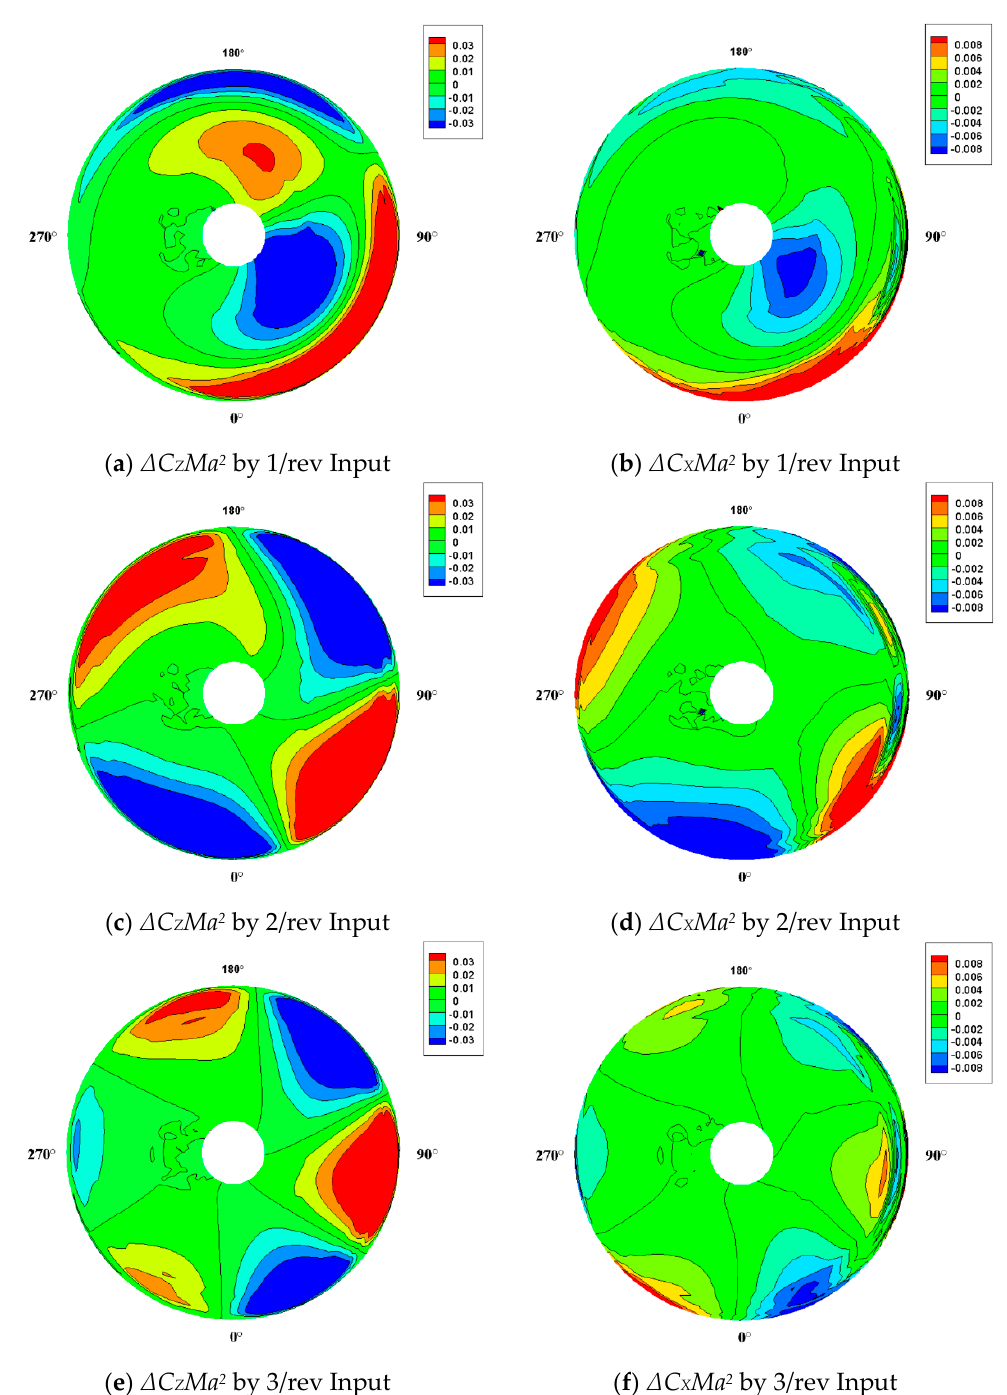
Figure 15. Dimensionless load increment distributions relative to the baseline rotor using uniform twist control with the 1~3/rev single-harmonic inputs for condition B.